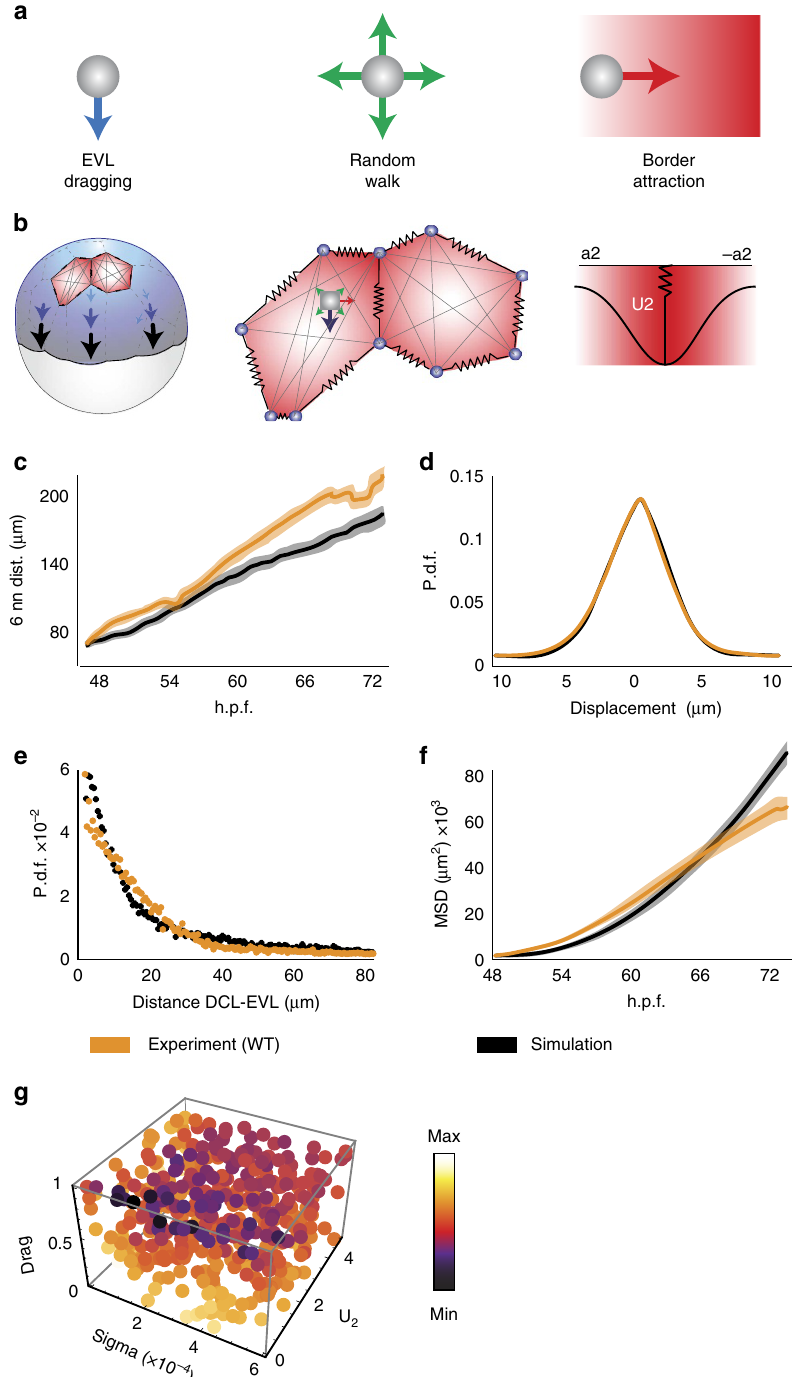
Figure 9 | Model of three forces driving DCL spreading. ( a ) Proposed physical model of three forces driving spreading of the embryonic DCL. ( b ) Schematic diagram of the simulation model, based on interacting point particles (EVL vertices, DCL cells) confined to move on the surface of a sphere. EVL vertices (blue circles) are connected by springs that move and expand under a constant velocity from the EVL epithelial margin (border condition). DCL cells (grey circles) move with an autonomous random walk, and are influenced by non-autonomous forces of EVL dragging and short-range EVL cell border attraction. Attraction is determined by a gaussian potential along EVL cell borders with length a 2 and amplitude U 2 (see Methods). ( c – f ) Comparison of four functions of DCL spreading between simulations (black lines) and experimental data (orange lines) (Supplementary Movie 9). The mean distance to the six nearest neighbours within the DCL ( c ) is a measure of cell dispersion. The probability density function of the displacement of DCL cells ( d ) is a measure of noise. The probability distribution of the distance of DCL cells to the nearest EVL cell border ( e ) is a measure of the spatial segregation of DCL cells to EVL cell borders. The mean square displacement ( f ) is a measure of the area explored by cells for any given time interval. ( g ) Sampling of the free parameters D (drag), s (sigma) and U 2 . Colours indicate the normalized values of the target functions (according to the colour scale on the right) for different values of the free parameters. Minimum values concentrate around drag B 1, s B 2 (cid:3) 10 4 and U 2 B